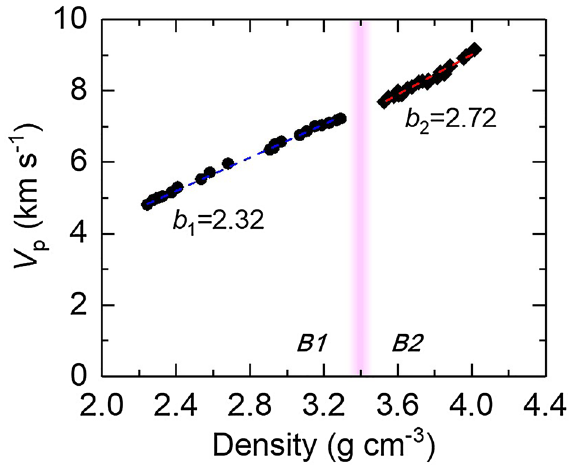
Figure 5. Compressional velocity V p of NaCl as a function of density. The V p is derived from the Brillouin frequency data (Fig. 4) and the refractive index N by the Lorentz-Lorenz equation (see the text for details). The density is calculated by the equations of state of NaCl in B1 and B2 phases. The V p approximately linearly scales with the density, following the Birch’s law, with a slope of b 1 = 2.32 (blue dashed line) and b 2 = 2.72 (red dashed line) in B1 and B2 phase, respectively. The pink shaded region labels the B1–B2